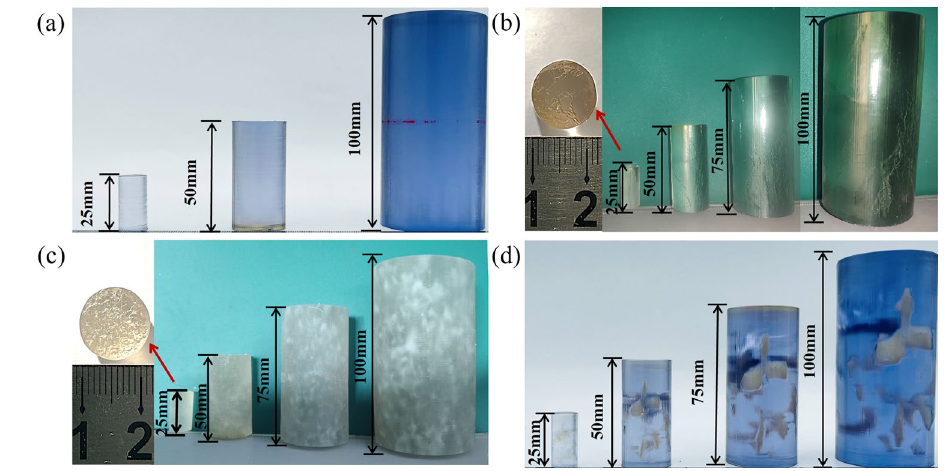
Fig. 5 Printed specimens of various sizes. a Homogeneous model; b Fractured model with real cleavages; c Porous model with real pores and d Porous model with amplified pores